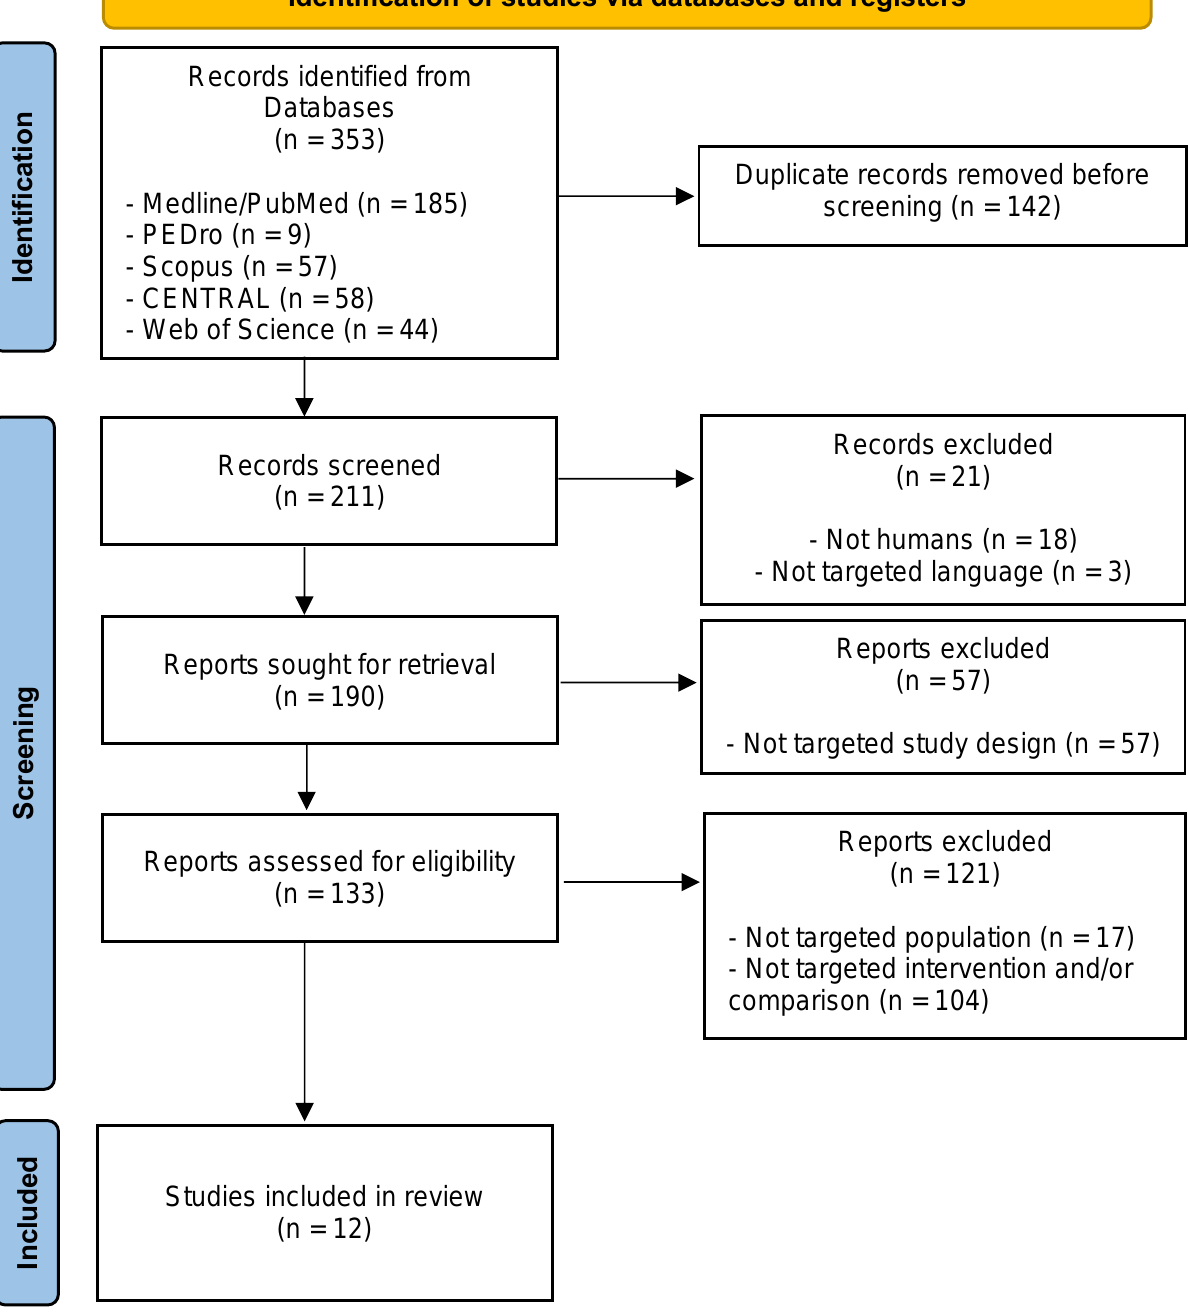
Figure 1. Flow diagram of the different phases of the systematic review. Table 1. Main characteristics of the studies included in the systematic review.